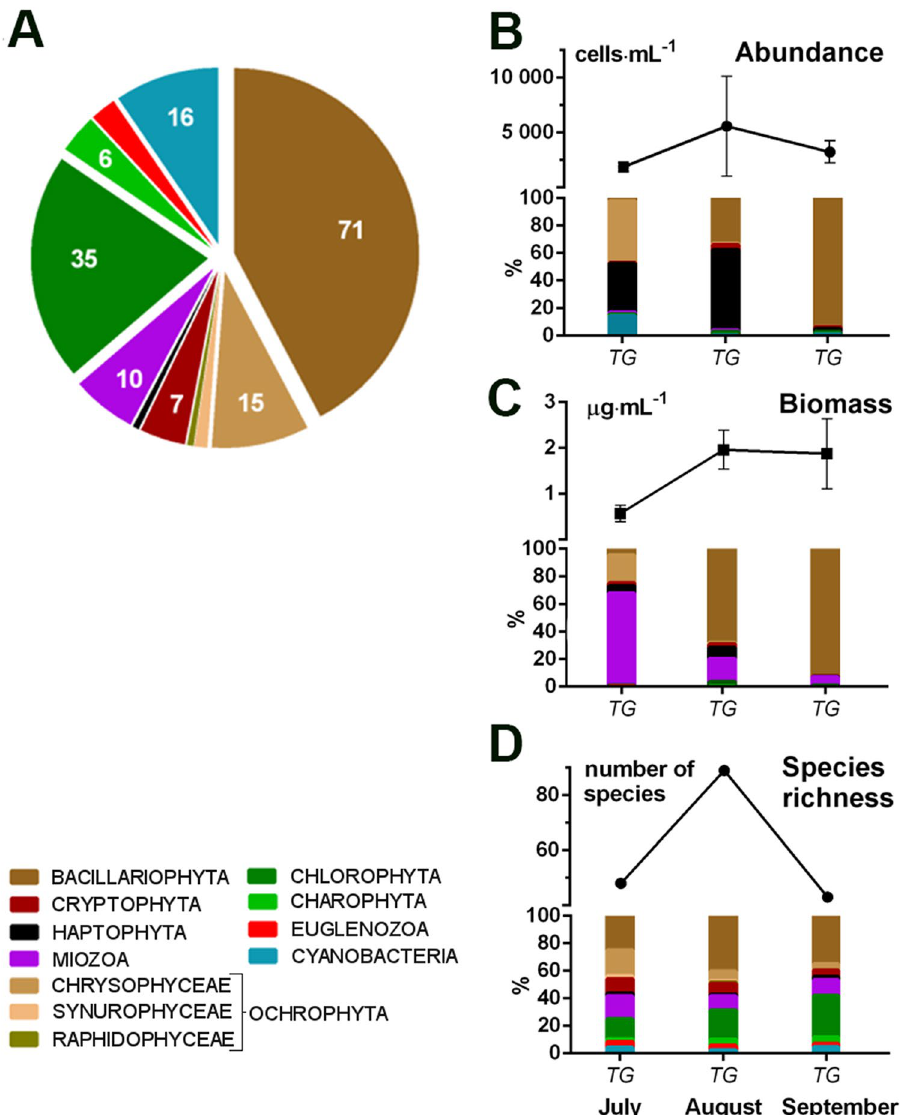
Figure 2. Community composition of major taxonomic groups of phytoplankton in Lake Shchuchie defined by light microscopy. ( A ) Contribution of identified species belonging to major taxonomic groups; ( B ) total and relative abundance of taxonomic groups; ( C ) total and relative biomass of taxonomic groups; ( D ) total and relative species’ number per taxonomic groups. Mean values ± Std